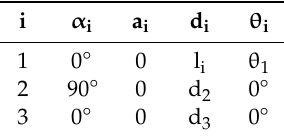
Table 6. List of parameters for the D-H transformation